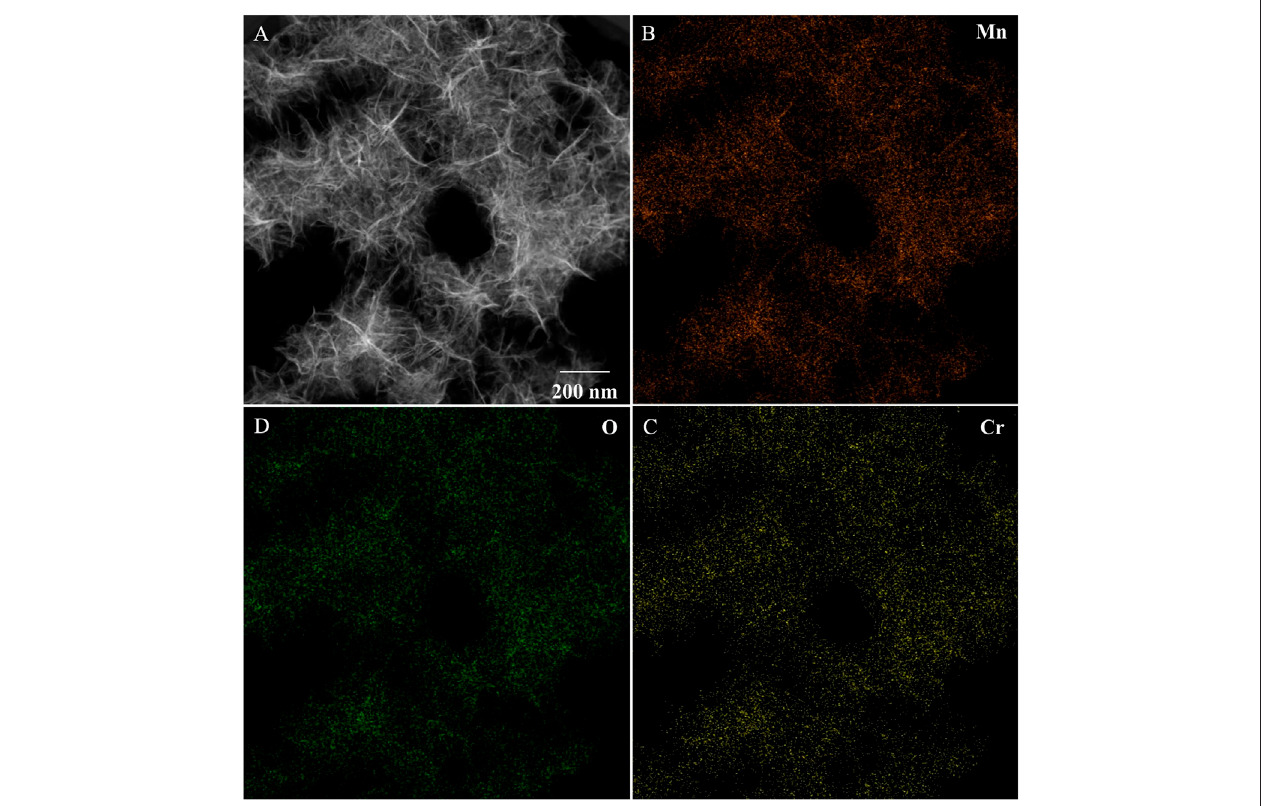
FIGURE 3 | STEM (A) and EDS-mapping (B – D) images of Cr 2 O 3 /MnO 2-x .